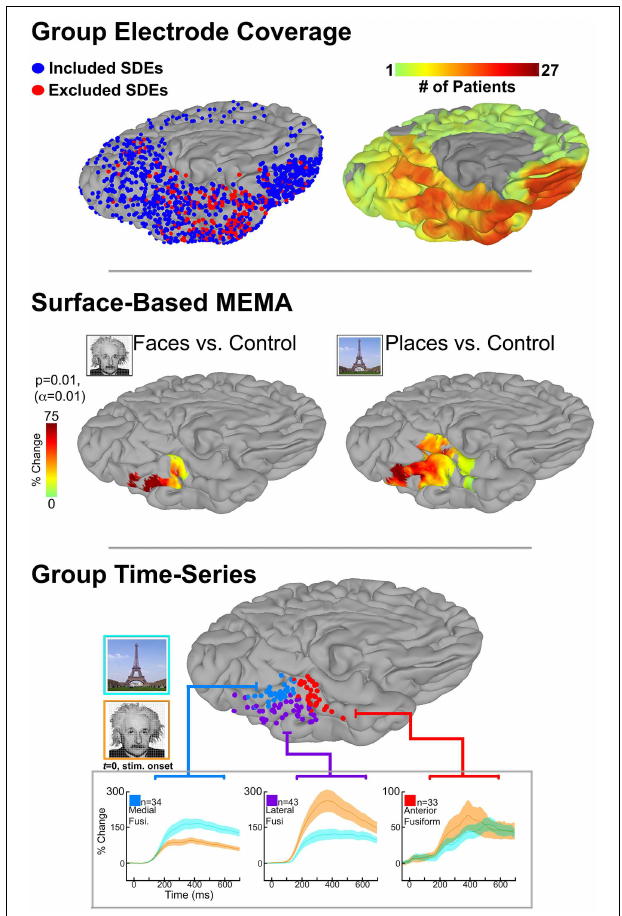
FIGURE 1 | Top: icEEG data were collected in 27 patients, implanted with subdural electrodes (SDEs) in the left hemisphere, as they performed a visual confrontation naming of famous faces, places, and scrambled control images. Surface-based representations of SDE coverage and high-frequency broadband gamma activity (BGA; 60–120Hz) were generated for each subject. We utilize cortical surface models that have been reconstructed from each subject’s pre-implantation high-resolution anatomical MRI scans (Phillips Medical; T1-weighted, 1mm isotropic resolution; using FreeSurfer software), and subsequently imported to the SUMA module of AFNI. Surface-based datasets of SDE coverage and BGA are generated with respect to each subject’s cortical model using geodesic metrics to correct for local gyral and sulcal folding patterns. By spatially transforming data to the cortical surface, we integrate SUMA’s surface-based normalization strategy to convert individual datasets to a standardized cortical surface (N27). To achieve this, SUMA resamples individual cortical models (and therefore their associated datasets) to a standardized mesh and enables a one-to-one correspondence between anatomical locations across subjects. Group maps for electrode (left) and surface-based coverage (right) are shown for the ventral temporal cortex. SDEs are modeled as spheres, with red spheres indicated SDEs that were excluded due to 60Hz line noise or epileptiform activity. By grouping data in this fashion, comprehensive cortical coverage is obtained, and cognitive function can be critically evaluated at spatio-temporal scales relevant to neural processes. Middle: SB-MEMA derived significant grouped effects estimates by comparing composite BGA percent change (50–500ms post-stim; with respect to pre-stimulus baseline of − 700 to –200ms) for each stimulus category against its scrambled control. Notably, BGA to faces was